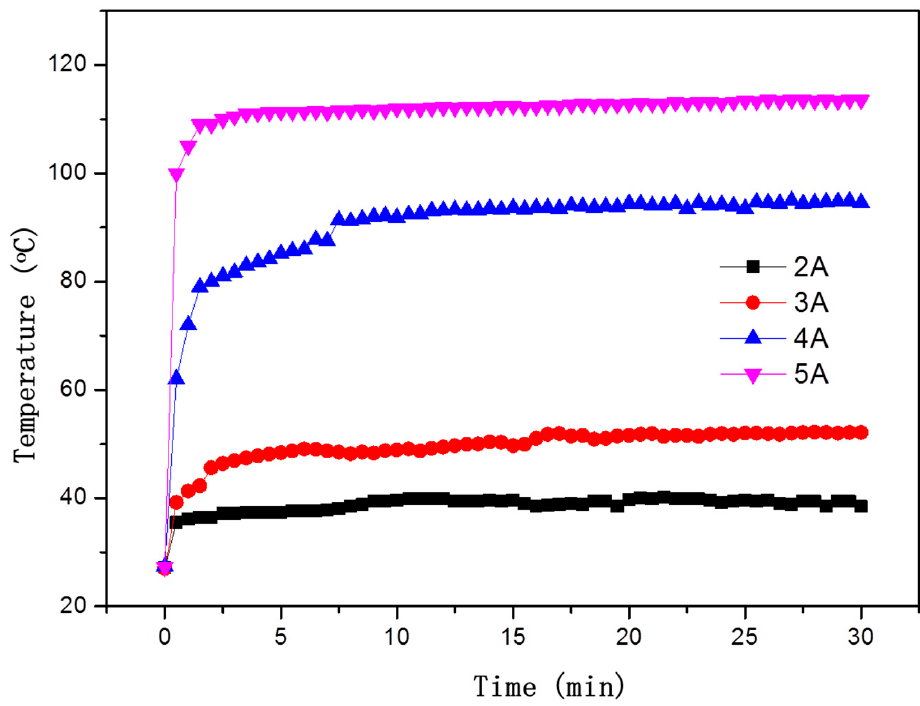
Figure 5. The relationship between surface temperature and time of CFRE plate under different conduction currents.